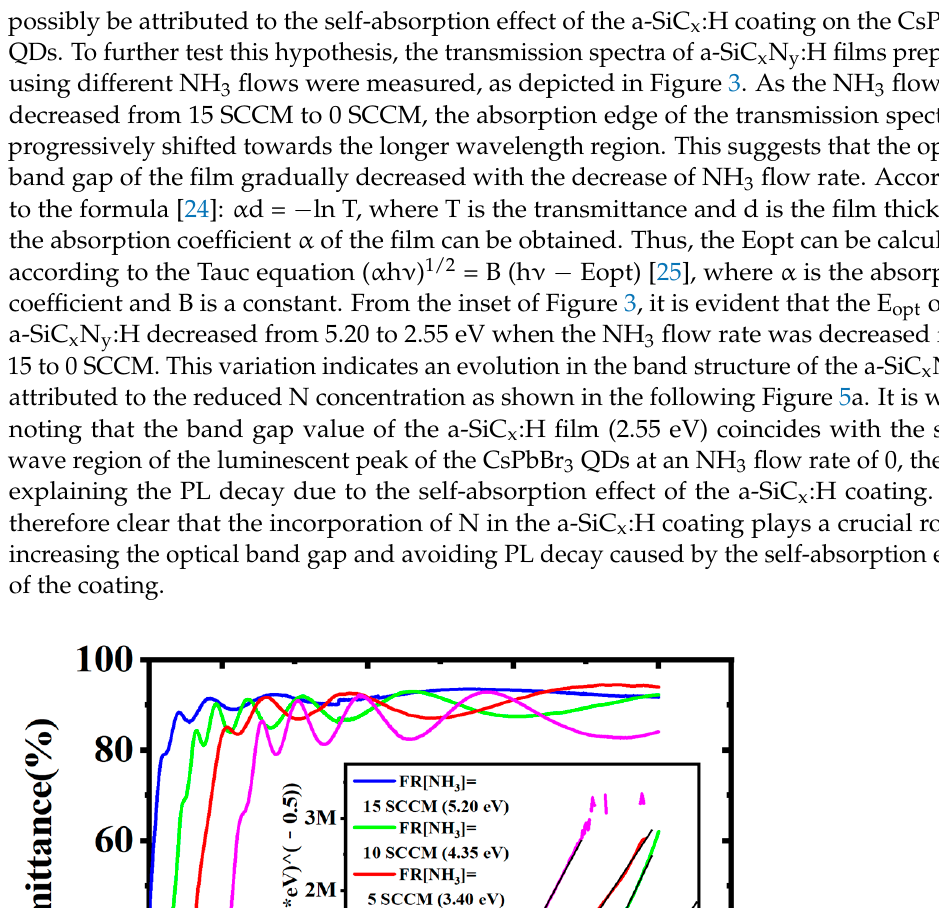
Figure 3. Transmission spectra of the a-SiC x N y :H films fabricated with different NH 3 flow rates. Inset shows the Tauc plots of the corresponding a-SiC x N y :H